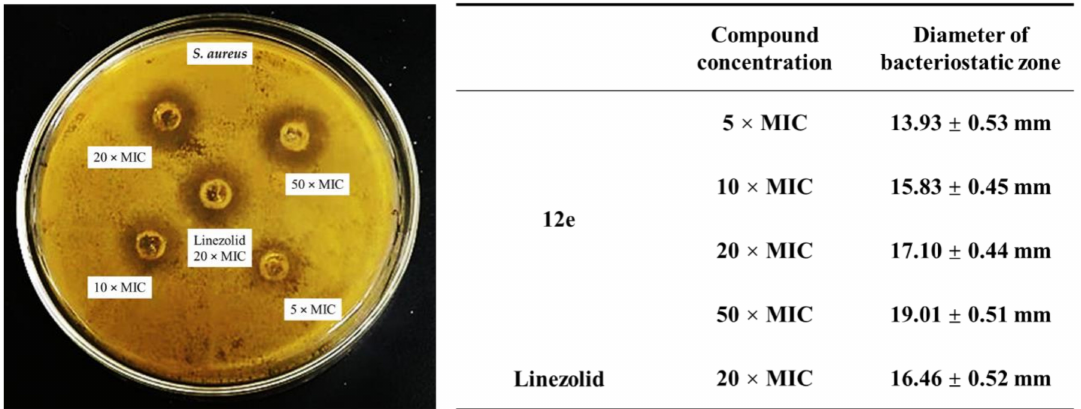
Figure 2. Bacteriostatic zone of 12e against S. aureus at different concentrations. (MIC: minimal inhibit concentration).